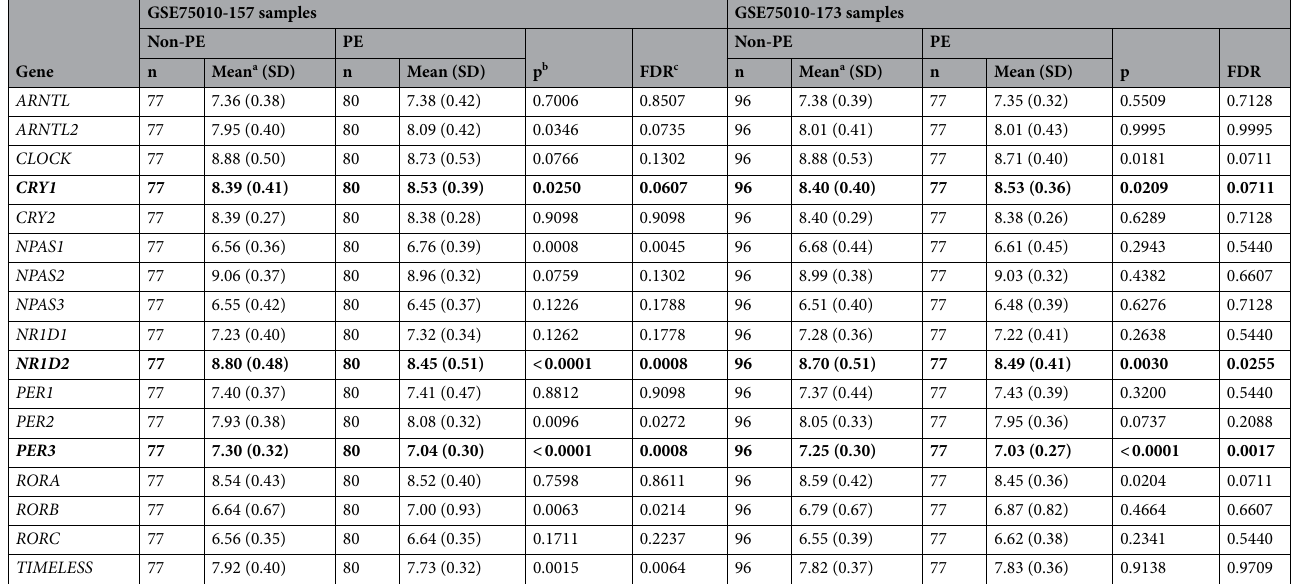
Table 1. Descriptive statistics of 17 candidate circadian clock genes’ expression levels in placenta from PE vs. non-PE, independent of gestation length (overall PE vs overall non-PE, respectively), in two independent datasets. a Mean of gene expression values, normalized and log2-transformed. The mean change percentages of 3 circadian genes’ expression levels are: for CRY1 gene, (8.53–8.39)*100/8.39 = 1.7% in GSE75010-157 Samples and (8.53–8.40)*100/8.40 = 1.5% in GSE75010-173 Samples; for NR1D2 gene, (8.80–8.45)*100/8.80 = 4.0% in GSE75010-157 Samples and (8.70–8.49)*100/8.70 = 2.4% in GSE75010-173 Samples; and for PER3 gene, (7.30– 7.04)*100/7.30 = 3.6% in GSE75010-157 Samples and (7.25–7.03)*100/7.25 = 3.0% in GSE75010-173 Samples. b Two-sample, two-tailed t-tests were used to generate p-values. Bold values denote statistical significance (p < 0.05 and FDR < 0.10) in both datasets.